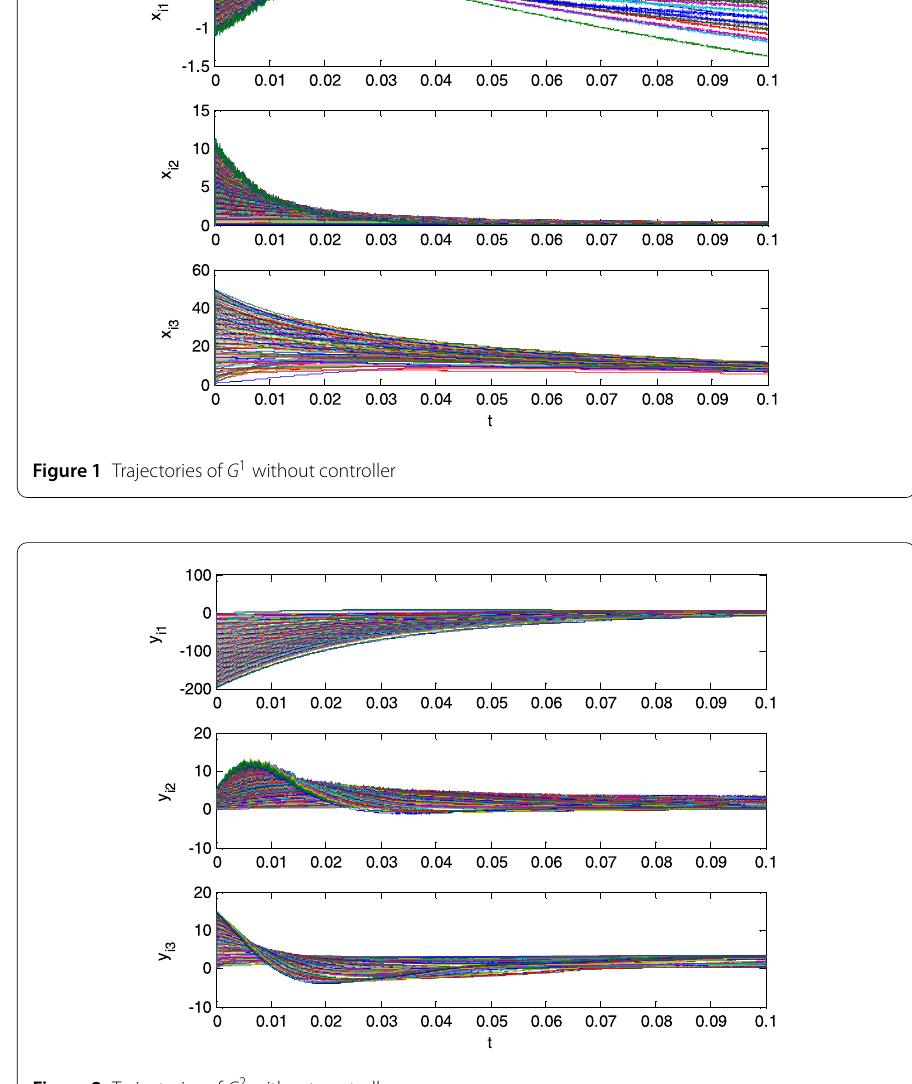
Figure 2 Trajectories of G 2 without